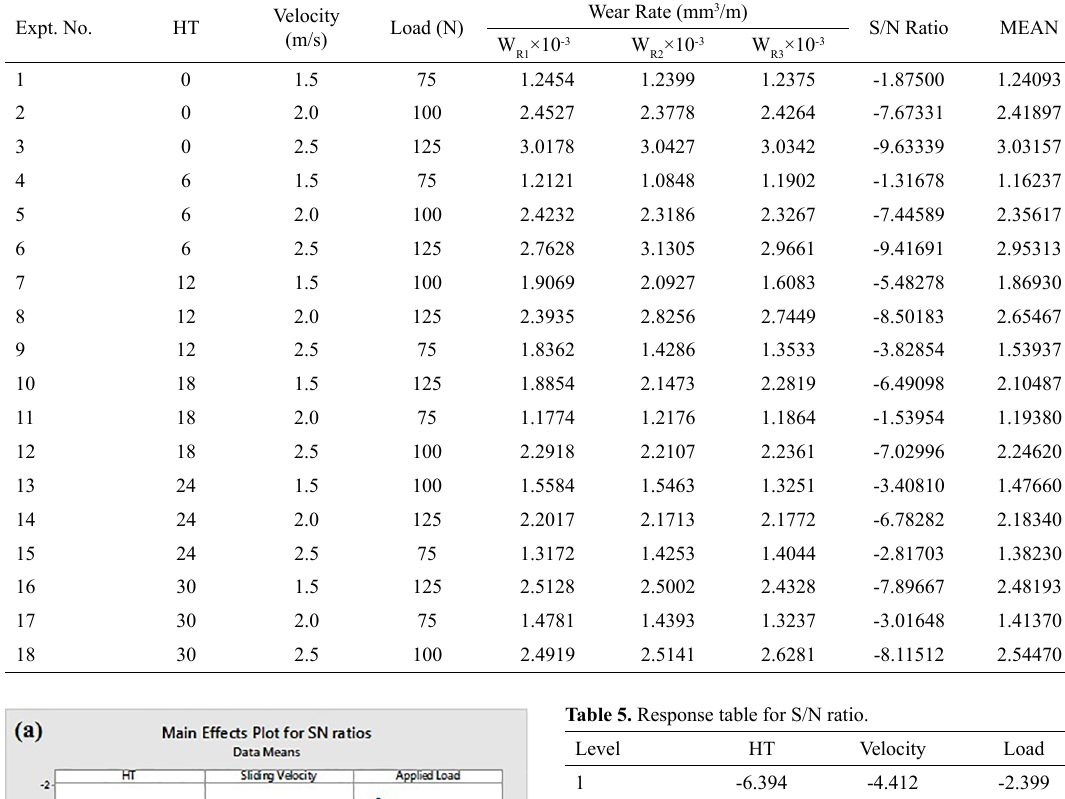
Table 4. L18 OA with response and S/N ratio.